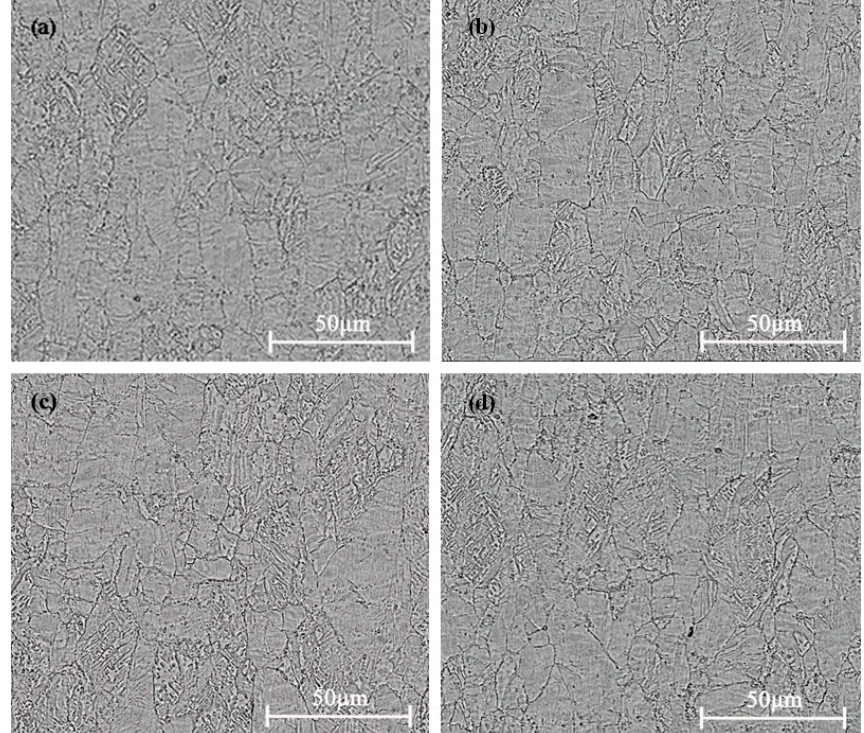
Figure 5. Microstructure of the Cu-1.34Ni-1.02Co-0.61Si alloy after cold rolling at 47% reduction with the DCT time in liquid nitrogen for ( a ) 0 h, ( b ) 6 h, ( c ) 24 h and ( d ) 48 h.